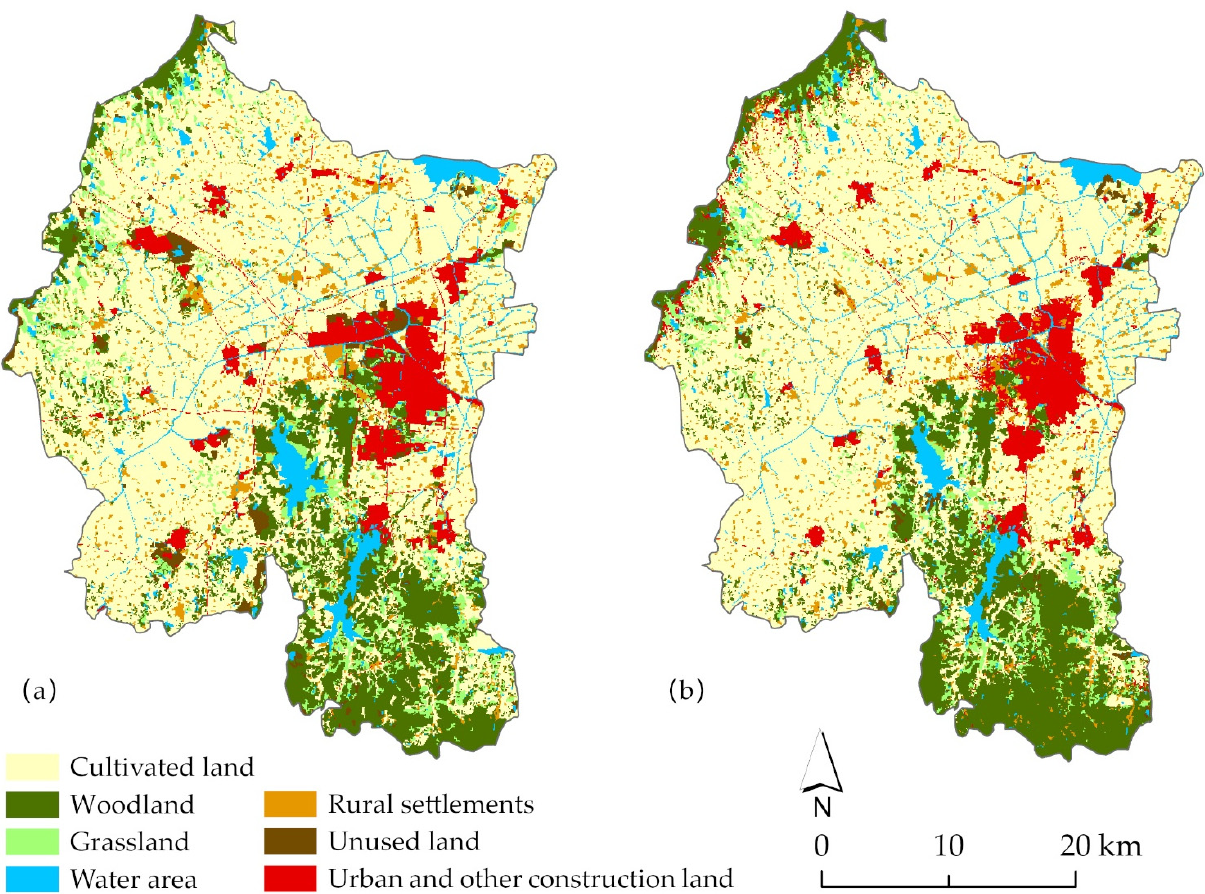
Figure 4. ( a ) 2020 land use map; ( b ) land use simulation of 2020.